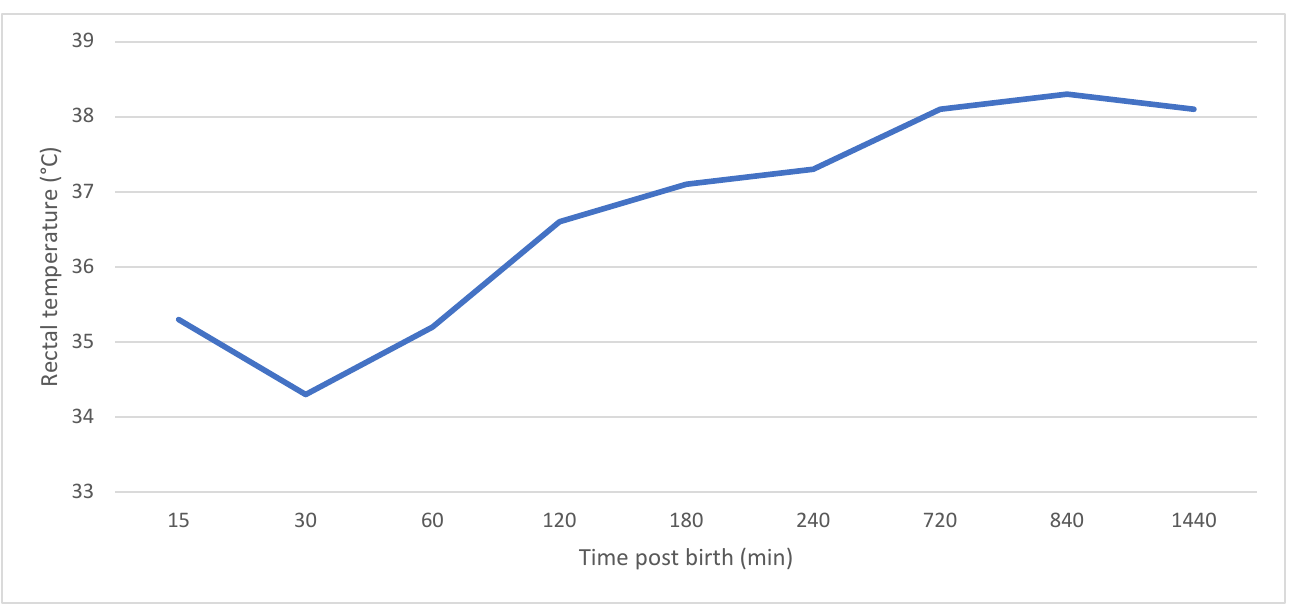
Figure 2. Piglet rectal temperature change from 15 min to 24 h post-partum. Modified from Anderson et al. [42].